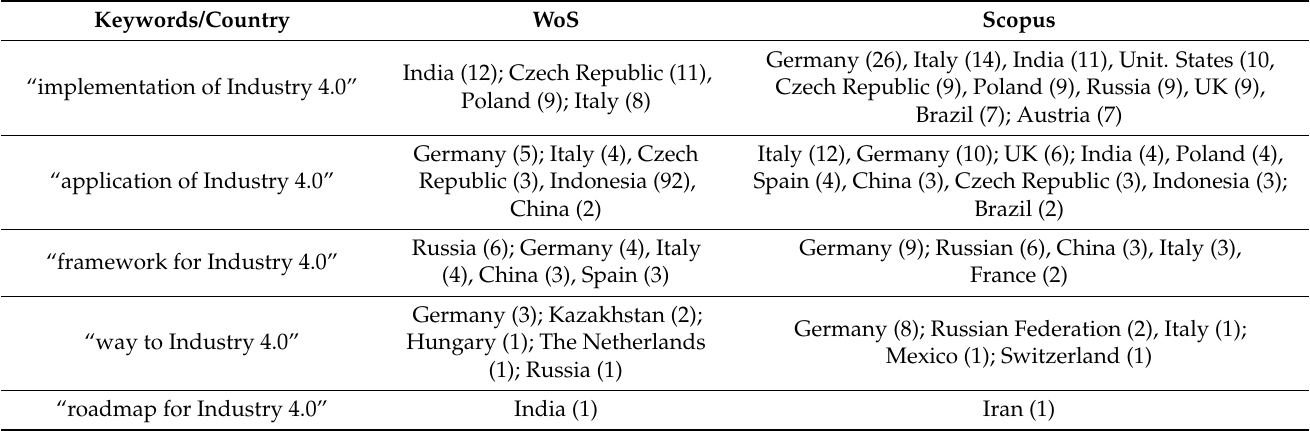
Table 8. Results of own literature review in the field: country.